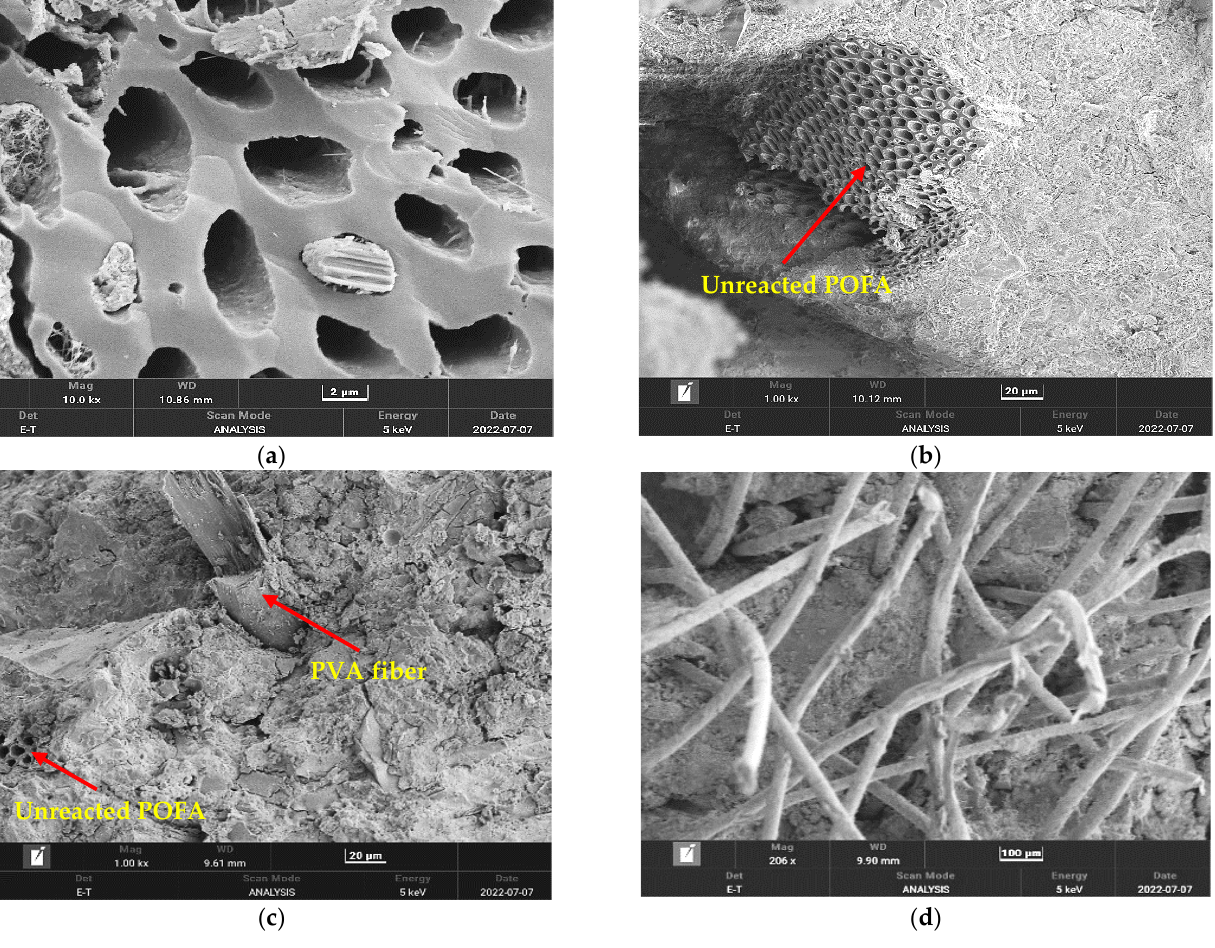
Figure 12. FESEM micrographs ( a ) section through POFA particle ( b ) Unreacted POFA in Mix 13 (40% POFA and 2% PVA) ( c ) Mix 1 (20% POFA and 1% PVA Fibers) showing relatively lower unreactive POFA ( d ) Mix 10 (30% POFA and 2% PVA Fibers) showing clumped fibers. Table 4. Critical pore parameters of